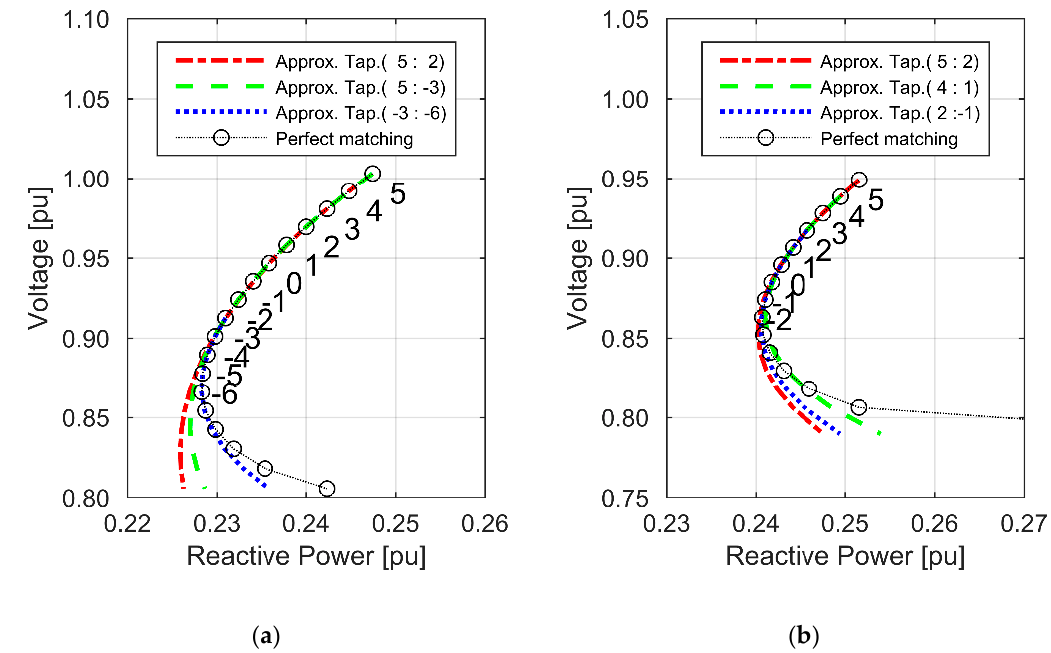
Figure 11. Characteristic V = f( Q ) approximation based on measurement points (numerical values correspond to the number of taps position): ( a ) case V MV(t = 0) = 1; ( b ) case V MV(t = 0) = 0.95.